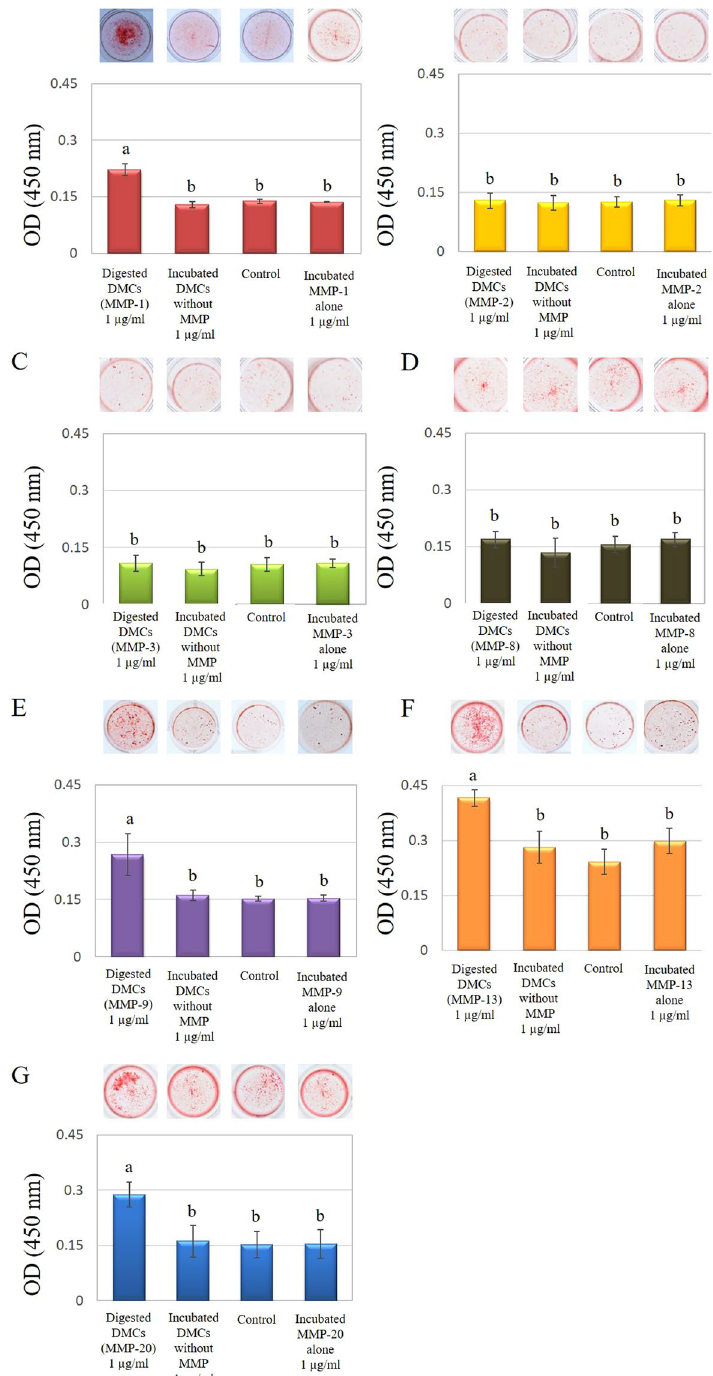
Figure 6. Effects of 1 µ g/ml of dentin matrix components (DMCs) treated with matrix metalloproteinase (MMP)-1 ( A ), MMP-2 ( B ), MMP-3 ( C ), MMP-8 ( D ), MMP-9 ( E ), MMP-13 ( E ), or MMP-20 ( F ) on mineralized nodule formation in rat primary pulp cells. Cells were exposed to 1 µ g/ml of MMP-treated DMCs, incubated DMCs without MMPs or medium alone containing 50 μ g/ml of ascorbic acid and 10 mm of β -glycerophosphate for 21 days. DMCs (1 µ g/ml) treated with MMP-1 ( A ), -9 ( E ), -13 ( F ), or -20 ( G ) significantly promoted mineralized nodule formation in pulp cell cultures after 21 days incubation (p < 0.05). Significant differences were not observed with DMCs treated with other MMPs, MMPs incubated alone or at lower concentrations (0.01–0.1 µ g/ml) of the above-mentioned MMPs (Supplementary Figure 8). Groups with similar lower-case letters (i.e., a and b) are not significantly different. Data represent five independent